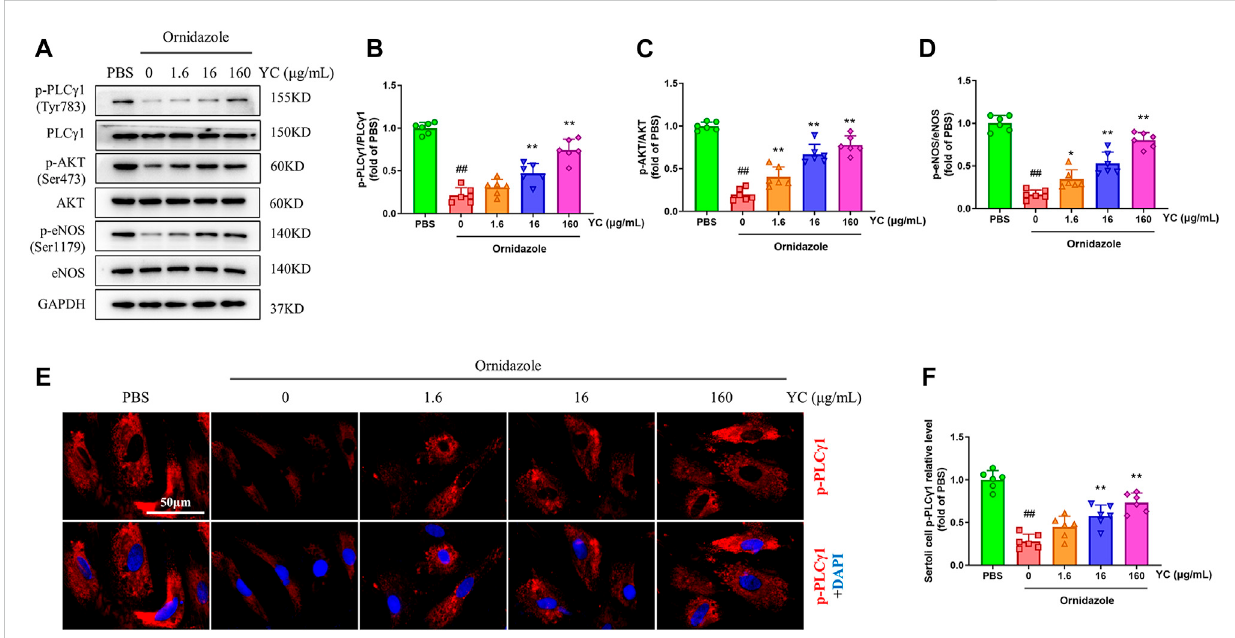
FIGURE 6 Changes of PLC γ 1/AKT/eNOS signaling in ornidazole-stimulated primary Sertoli cells. (A – D) Protein levels of p-PLC γ 1, p-AKT and p-eNOS were determined using western blot analysis. (E, F) Representative images and quanti fi cation of p-PLC γ 1 levels in the immuno fl uorescence assay. Values are shown as averages ± SD ( n = 6). ## p < 0.01 versus PBS group; * p < 0.05, ** p < 0.01 versus Ornidazole + YC (0) group.